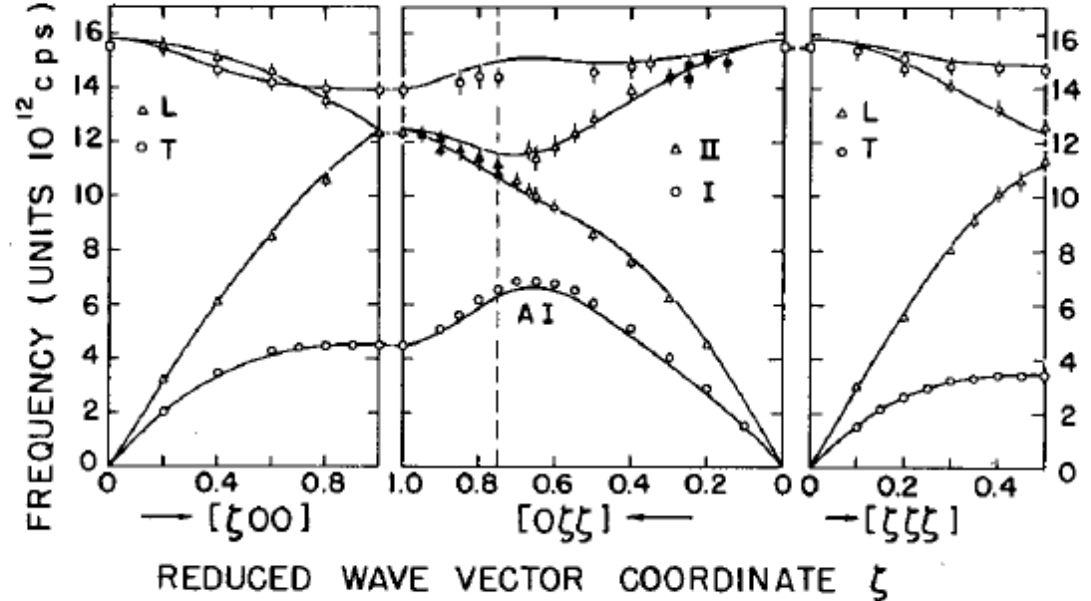
Figure 8. The phonon dispersion relations in silicon for the [ ζ 00], [0 ζζ ], and [ ζζζ ] directions at 296 K. The curves are calculated from shell model IIC. The vertical dashed line at ζ = 0.75 in the [0 ζζ ] direction marks the position of the zone boundary. Open circles represent type I [0 ζζ ] modes, open triangles represent longitudinal modes, and solid points have undetermined polarization. This figure is taken from Figure 1 of ref. [30] by courtesy of the International Atomic Energy Authority (IAEA).